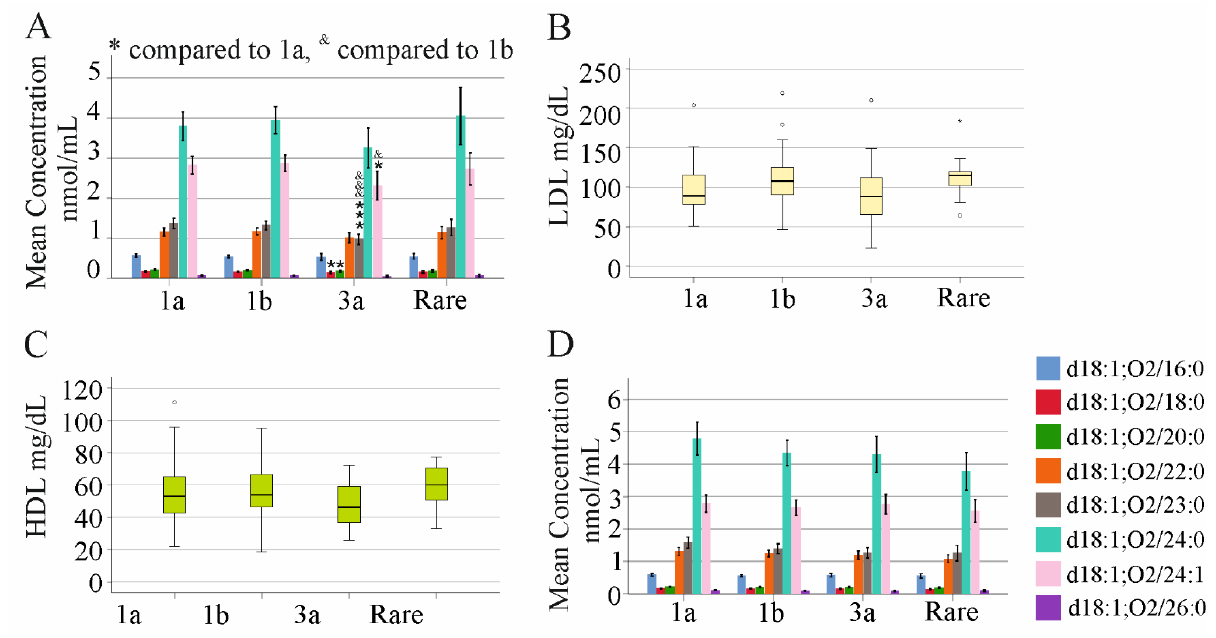
Figure 6. Ceramide levels stratified for viral genotypes . ( A ) Ceramides in serum of patients with different viral genotypes before therapy start; ( B ) LDL and ( C ) HDL levels of these patients; ( D ) ceramides in serum of patients with different viral genotypes at the end of therapy. * p < 0.05, *** p < 0.001, & p < 0.05, &&& p <